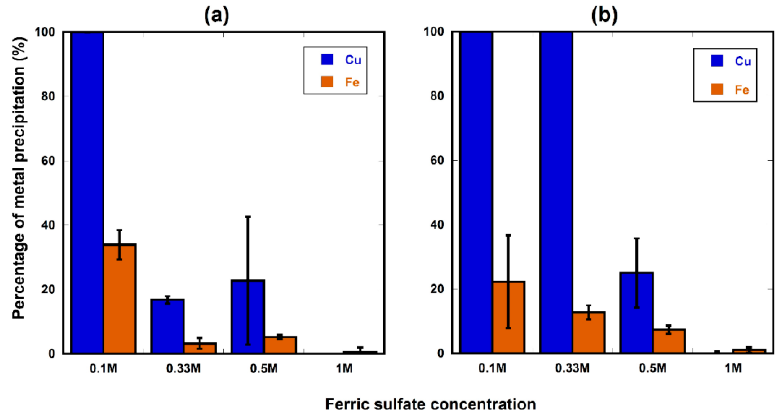
Figure 6. Effect of ferric sulfate concentration on copper sulfide precipitation. ( a ) Copper to sulfide ratio—1:5 and ( b ) Copper to sulfide ratio—1:10.